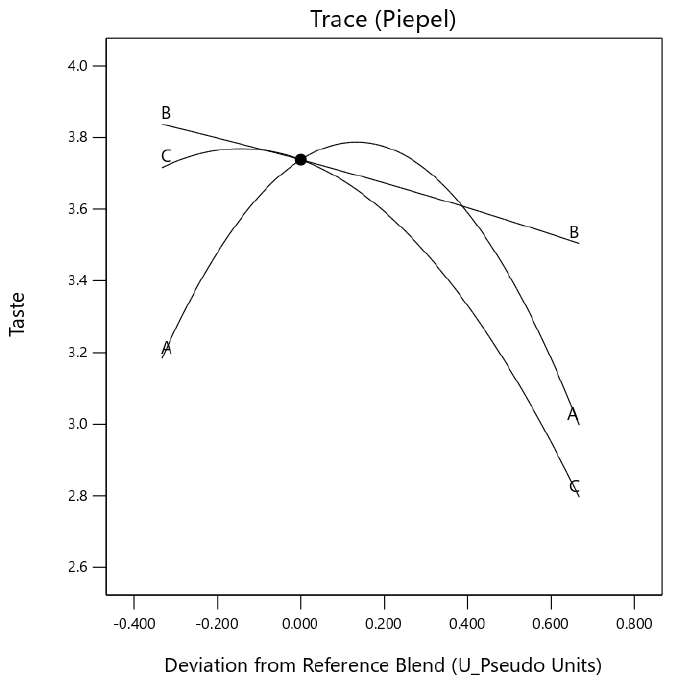
Figure 5. Trace (Piepel) plot for the effect of three components on taste (A: boiled egusi grit, B: flour and C hydrocolloid) on instant egusi soup.